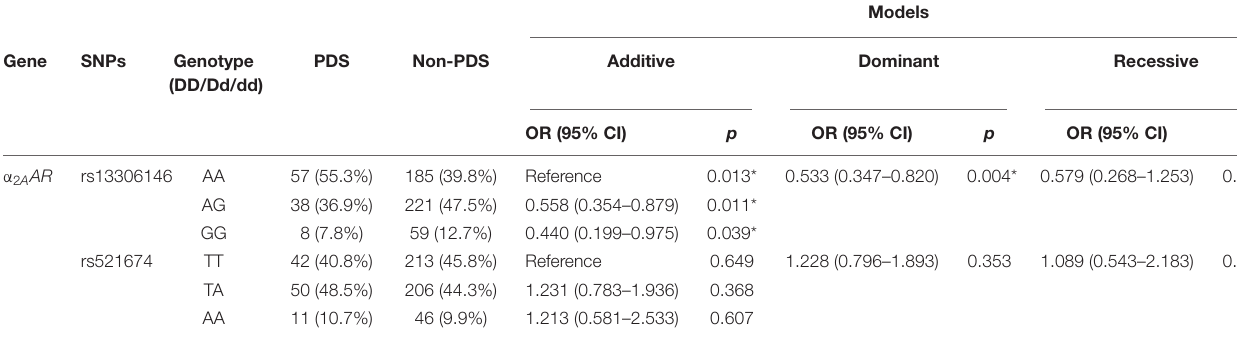
TABLE 2 | Correlation between α 2 A AR gene polymorphisms and postpartum depressive symptoms